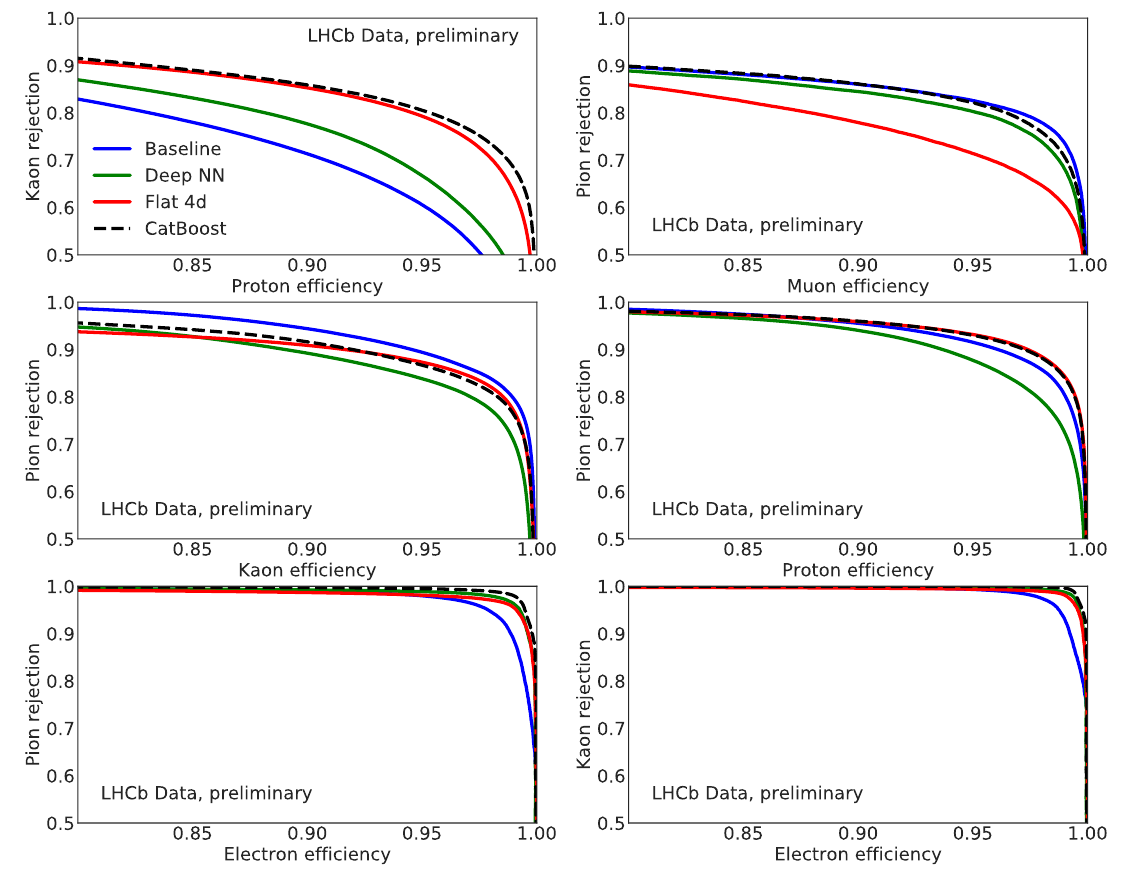
Figure 2. Dependences between background rejection and signal e ffi ciency for six particle